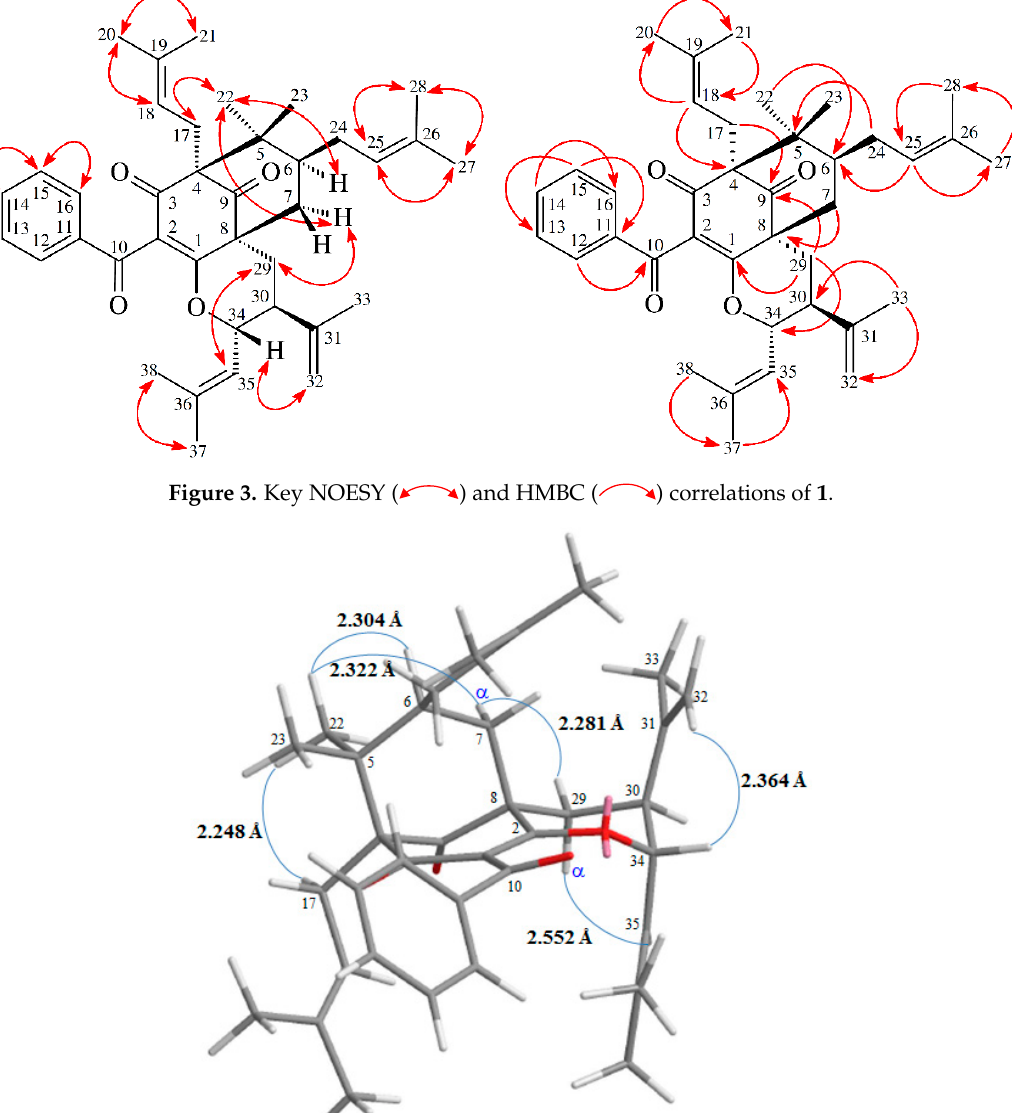
Figure 4. Selected NOESY correlations and relative configuration of 1 .